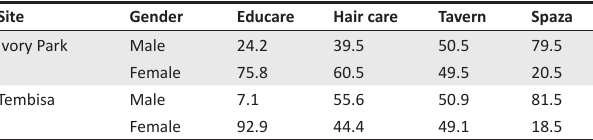
TABLE 3: Business ownership and/or gender ( % of enterprise category).